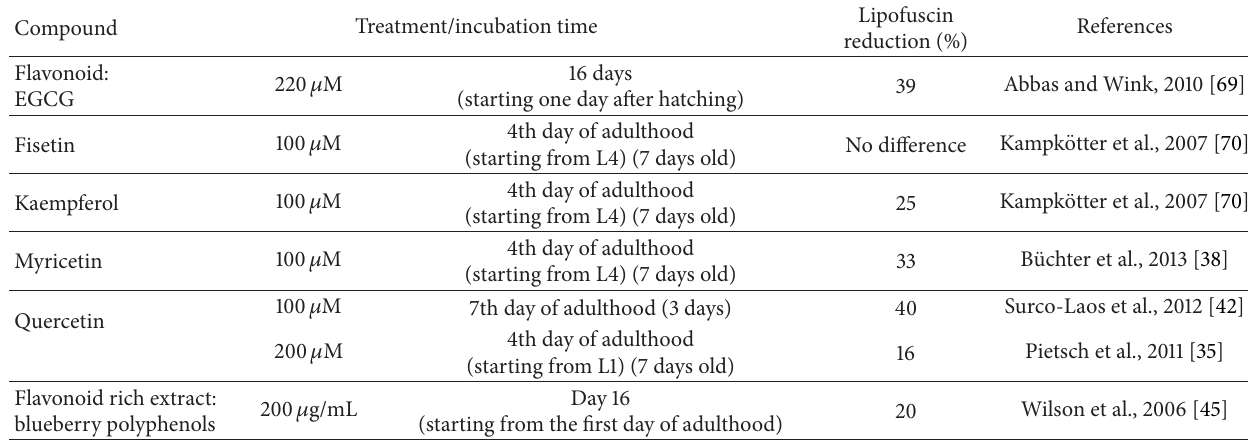
Table 3: Influence of flavonoids and flavonoid-rich extracts on lipofuscin levels in C. elegans .